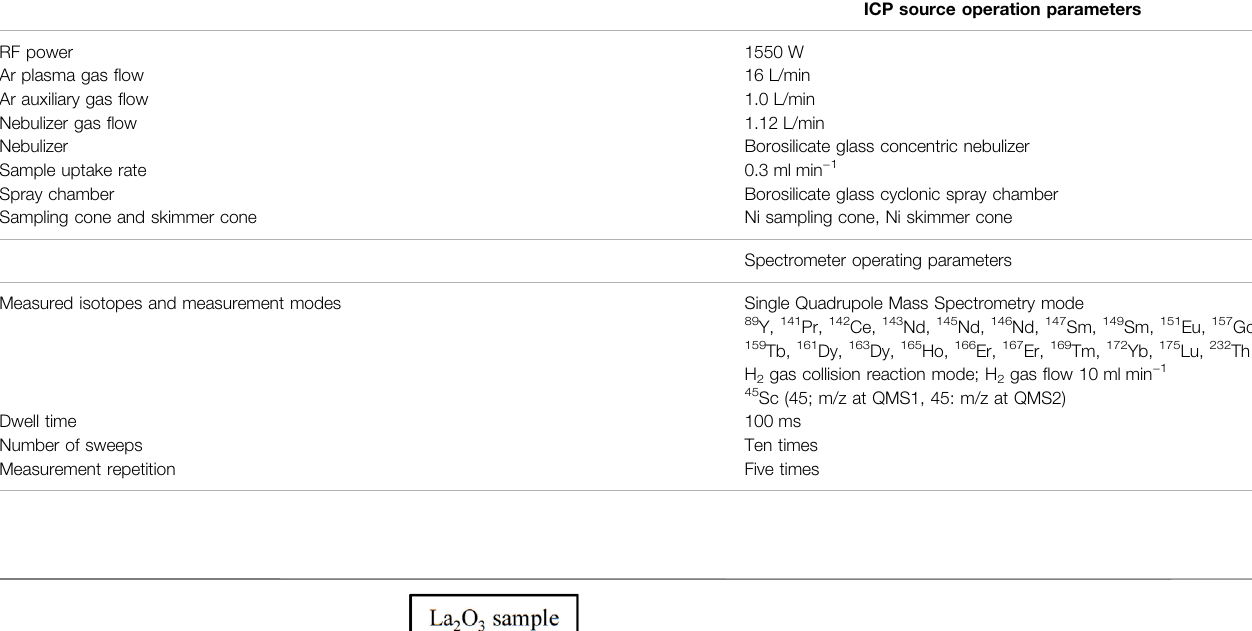
TABLE 1 | Instrumental conditions of Thermo Fisher iCAP TQ ICP-MS/MS for impurity analysis.